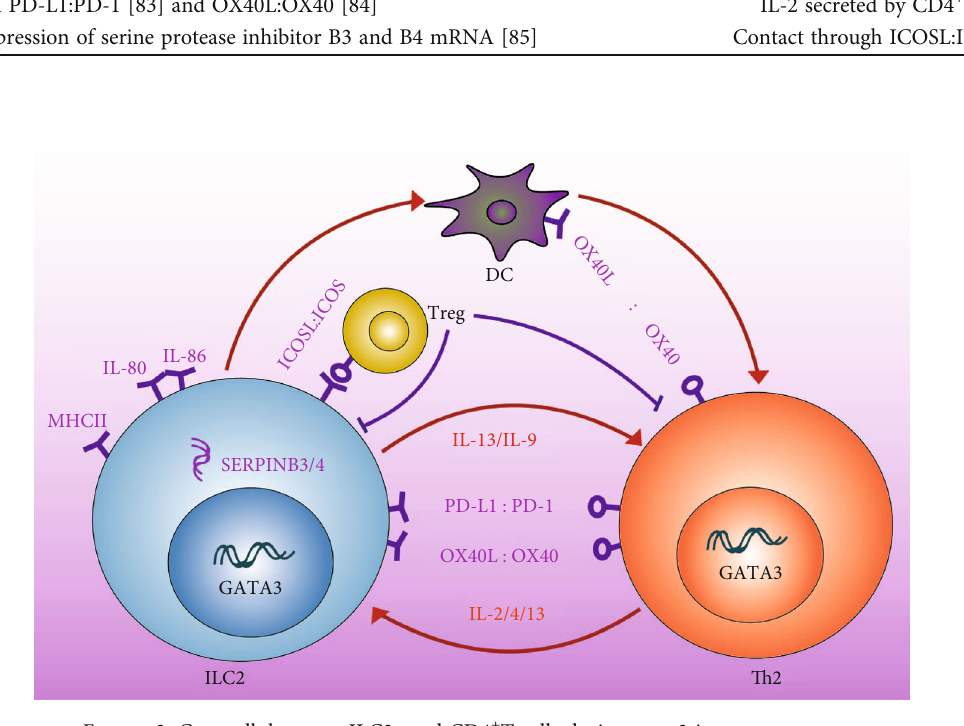
Figure 2: Crosstalk between ILC2s and CD4 + T cells during type 2 immune